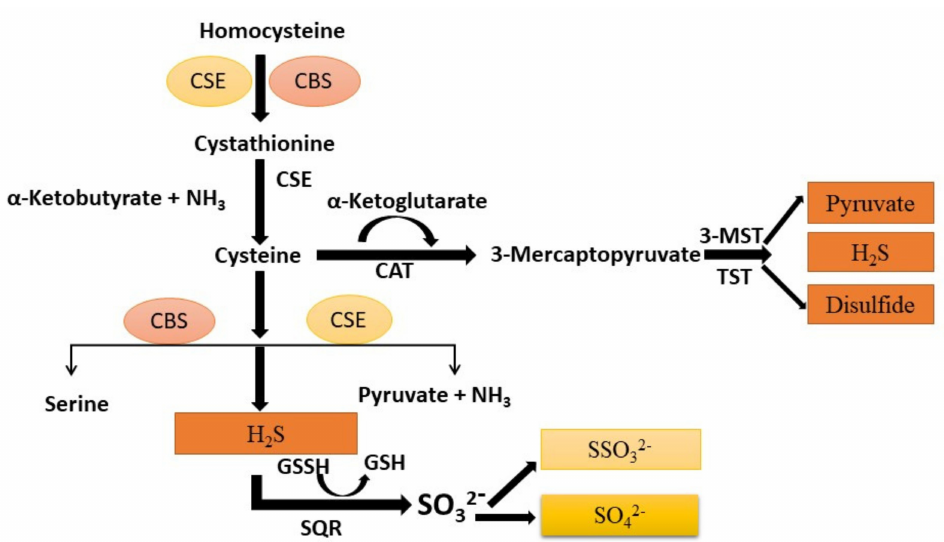
Figure 2. Illustration of vascular synthesis of H 2 S formed by a catalytic process in several enzymes (CSE, CBS, and 3-MSPT) in the lung. Cysteine is generated from homocysteine through transcultur- ation pathways intervened by CBS and CSE. H 2 S forms from homocysteine and cysteine via CBS and CSE. 3-MSPT forms 3-MST-cysteine persulfide (MST-SSH) using mercapto pyruvate, which is formed from cysteine via CAT. H 2 S is formed from MST-SSH via a non-enzymatic reaction. H 2 S is oxidized via sulfide oxidation to form thiosulfate and sulfate. H 2 S is produced from thiosul- fate through a non-enzymatic reaction through reductants via the catalytic activity of thiosulfate sulfurtransferase or 3-MST. H 2 S: hydrogen sulfide; SQR: sulfide-quinone reductase; CBS: cystathion- ine beta-synthase; CSE: cystathionine γ -lyase; 3-MPST: 3-mercaptopyravute sulfurtransferase; TST: thiosulfate sulfurtransferase; CAT: cysteine aminotransferase; GSSH: